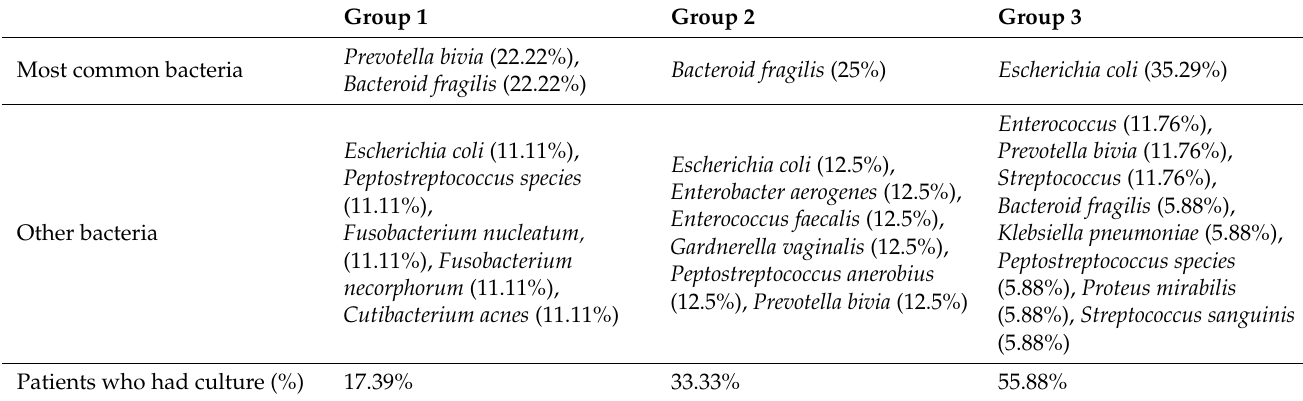
Table 5. Bacteria growth and antibiotics resistance rate among each